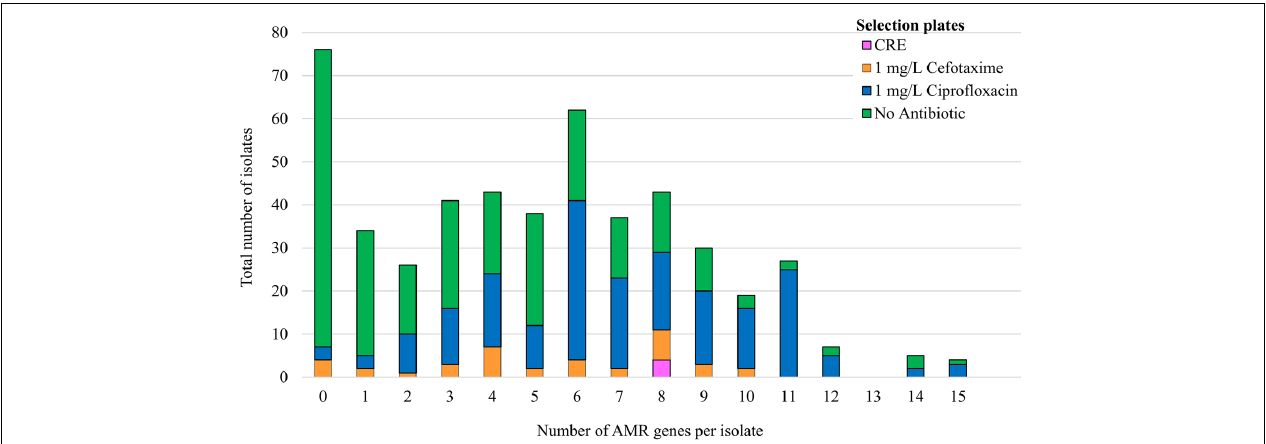
FIGURE 1 | Correlation of AMR genes harbored by isolates with the selection plate. The number of AMR genes detected by WGS in 492 isolates from 56 pigs farms. The colored bars indicate the number of isolates selected on agar supplemented with: antibiotic-free plate (green); 1 mg/L ciprofloxacin (blue); 1 mg/L cefotaxime (orange); or from Brilliance carbapenem -resistant Enterobacteriaceae Agar plates (CRE;